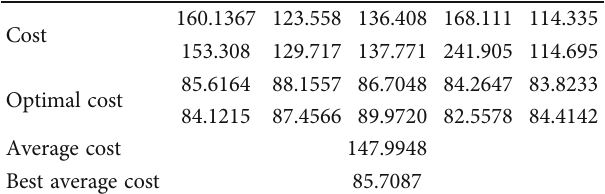
Table 7: Statistics of cost and optimal cost at di ff erent times.